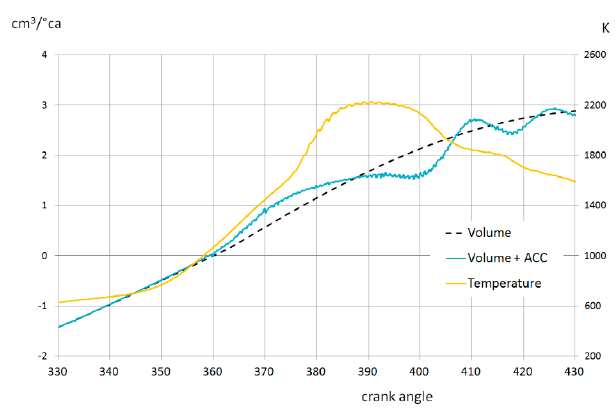
Figure 18. Temperature curve and volume changes (1500 rpm, 11 bar).